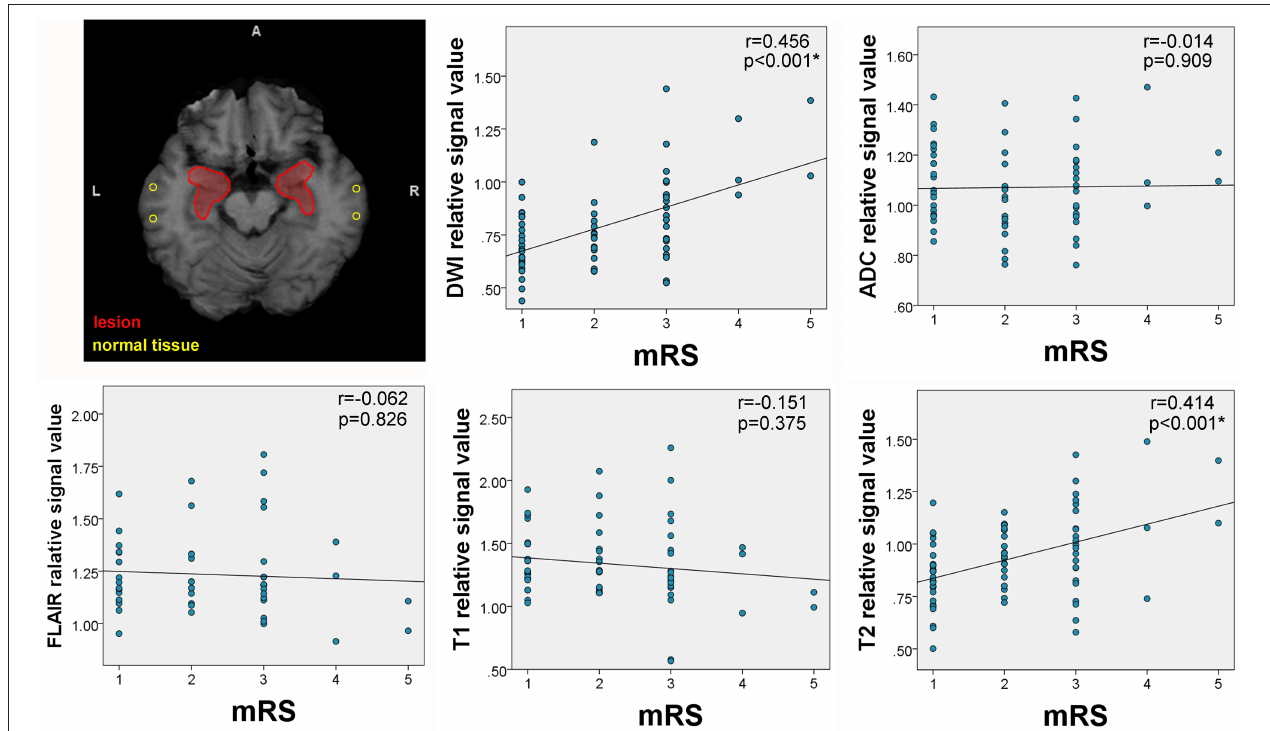
FIGURE 5 | Correlation between mRS and lesion signal measurements. The upper left corner shows the placement of regions of interest (ROIs) for signal measurements. The areas circled by red lines were created from lesion overlap maps and were used to extract lesion signals. The circular ROIs were used to extract normal tissue signals. Correlations between signal intensity and modified Rankin Scale (mRS) scores were observed on T2 and diffusion-weighted imaging